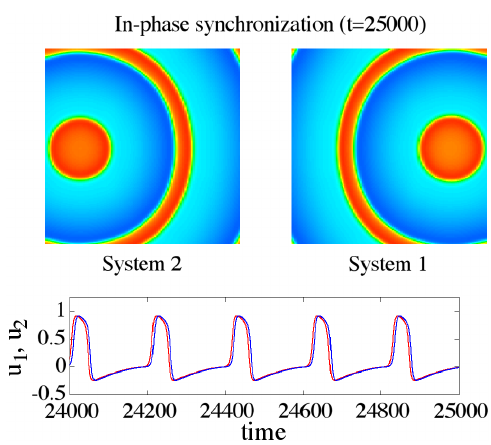
K ¼ diag ð k ¼ 5 × 10 − 4 ; 0 Þ . The initial phase difference is ϕ ð 0 Þ ¼ 1 . 38 . The bottom figure shows the evolution of the activator variables ð u 1 ; u 2 Þ at ð x; y Þ ¼ ð L= 4 ; L= 4 Þ of both